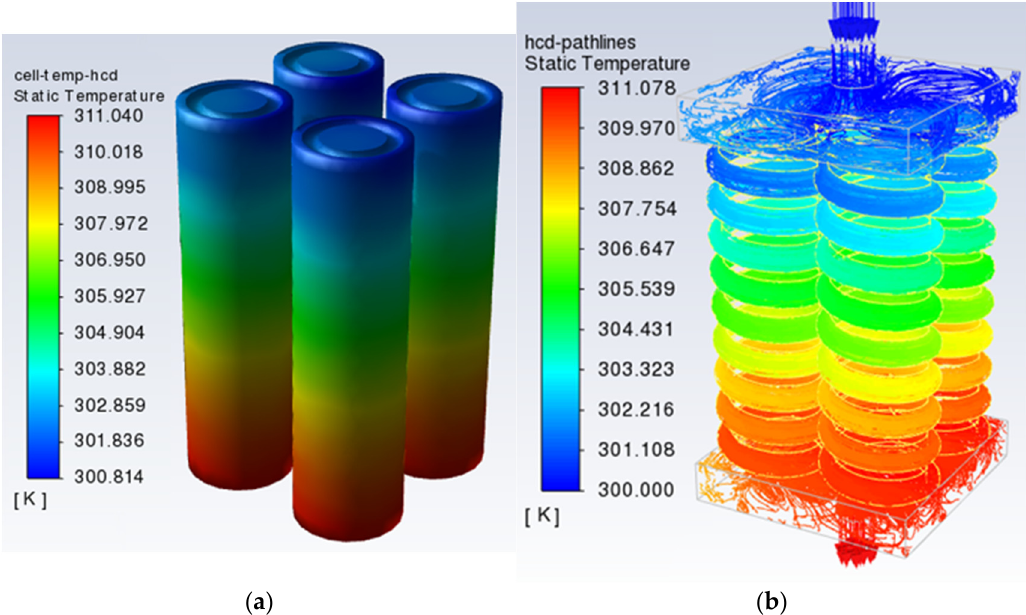
Figure 17. HCD contours: ( a ) Cell temperature (K); ( b ) Fluid pathlines.